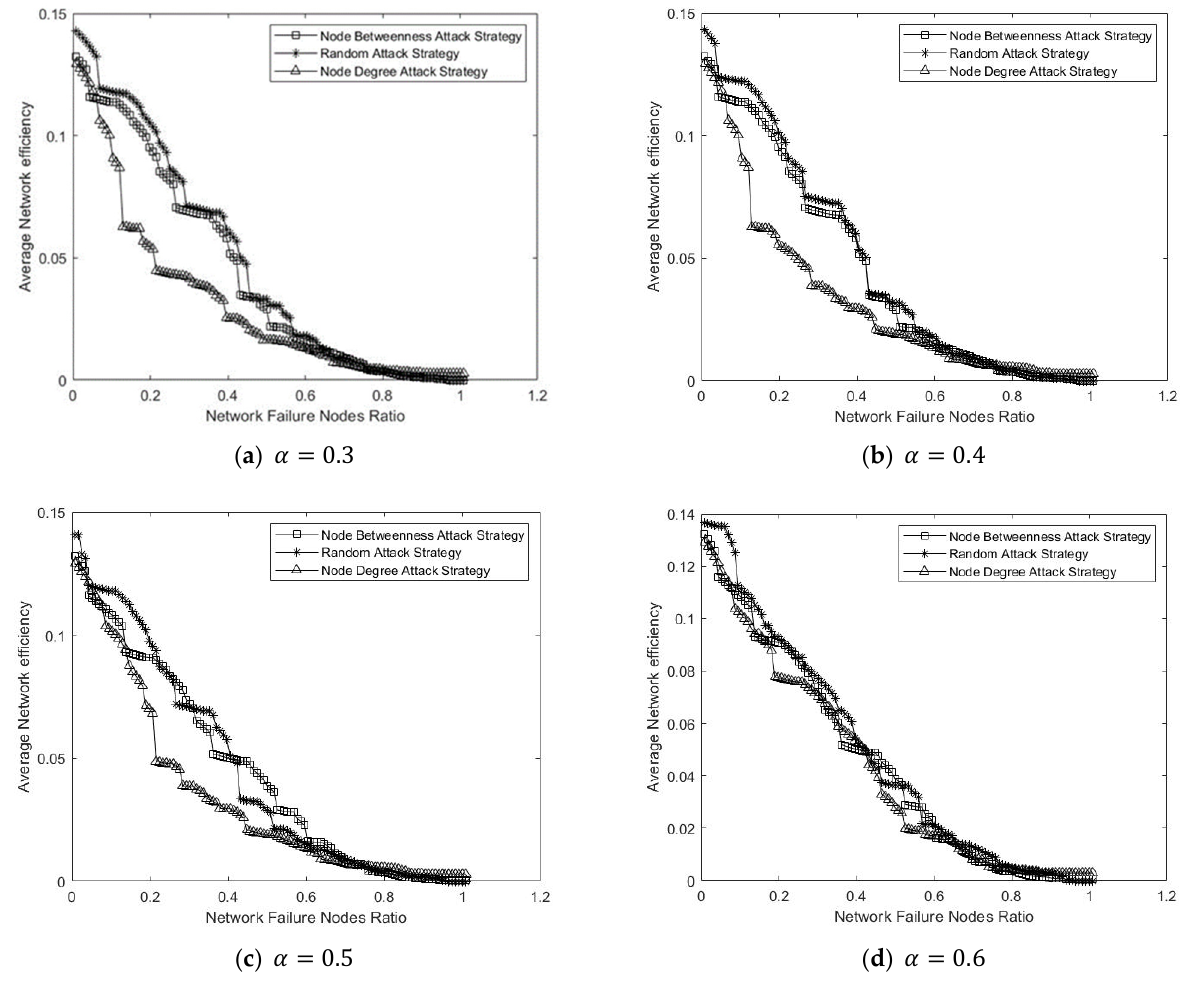
Figure 8. Average network efficiency with different tolerance factors.